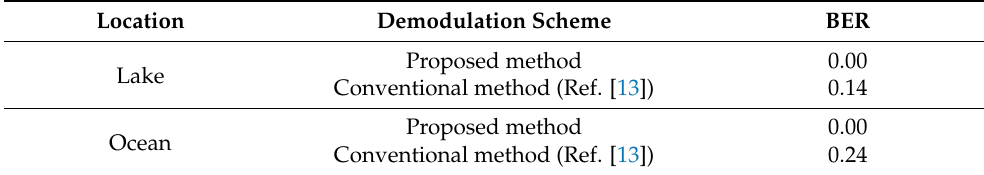
Table 7. BER results of the lake and the ocean experiments.